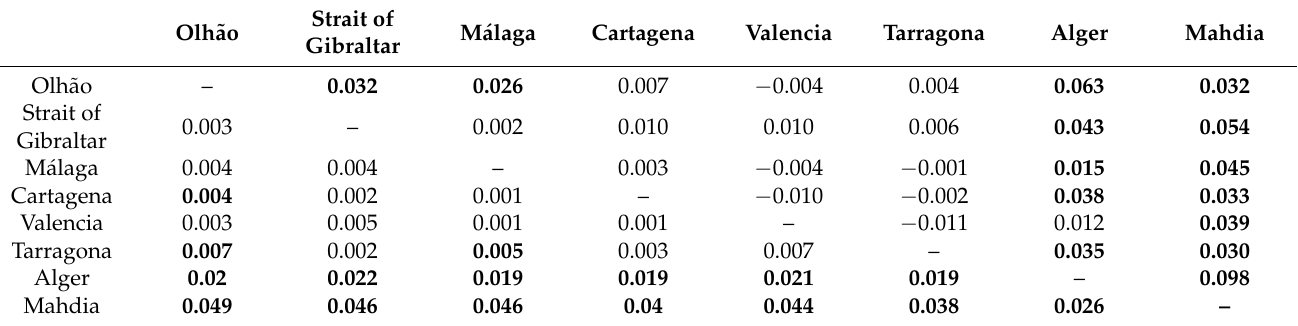
Table 2. Above diagonal φ ST pairwise comparisons between locations. Below are diagonal F ST pairwise comparisons for the 7 microsatellites loci from Arlequin. In bold, significant φ ST and F ST values ( p < 0.05).